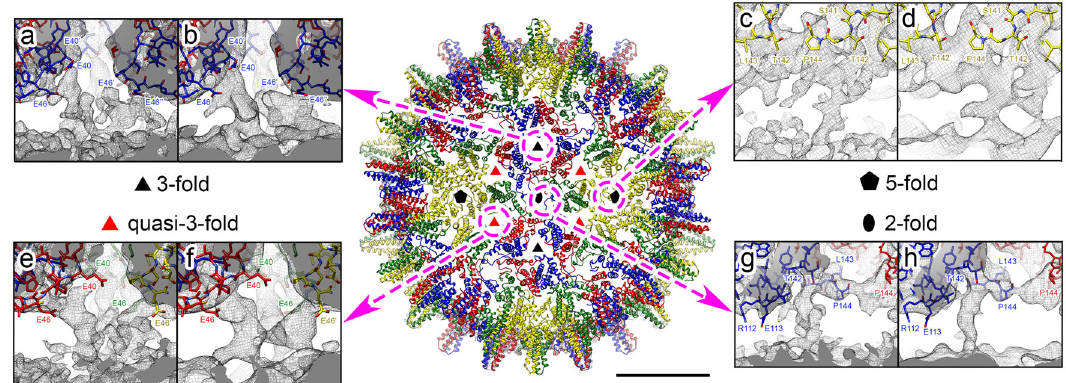
Fig. 4 Cryo-EM reconstruction of the T = 4 NCP formed with JQ707375.1 gRNA. Centre: Atomic model of the front-half of the HBV T = 4 NCP shown as ribbon diagrams, coloured in yellow (A monomer), green (B monomer), blue (C monomer) and red (D monomer) for the quasi-equivalent monomers, and viewed along a two-fold axis built into the icosahedrally-averaged cryo-EM density map at 3.2 Å resolution (bar = 100 Å). Symbols indicate icosahedral symmetry axes. a – h Dashed (pink) circles indicate the locations of individual NCP symmetry axes, including the quasi-3-fold, and the arrows lead to boxes showing the transiting internal density associated with each of these locations. Cryo-EM density maps are shown as a grey mesh with the centre of the NCP towards the bottom. Cp atomic models are shown as sticks. Amino acid side-chains adjacent to the internal layer of density are indicated and coloured by heteroatom. The atomic model is fi tted into the non- fi ltered shell of the Class 3 density map obtained after symmetry expansion and focused classi fi cation ( a , c , e , g ), and for clarity into the same map low-pass fi ltered to 5 Å ( b , d , f , h ), both shown at 1.5 σ . a , b Contacts located at three-fold vertices involve the E40-C48 sequence in Cp (including the E40-C43 alpha-helix and the S44-C48 loop) of three C monomers. The side chains of residues E40 and E46 are directly pointing to the internal density shell. c , d Contacts located at fi ve-fold vertices involve fi ve A monomers (pentamer). e , f Contacts located at quasi-three-fold vertices involve the E40-C48 sequence in Cp (including the E40-C43 alpha-helix and the S44-C48 loop) of one A monomer, one B monomer and one D monomer. The side chains of residues E40 and E46 point directly at the internal density shell. g , h Contacts located at two-fold vertices involve two C monomers and two D monomers